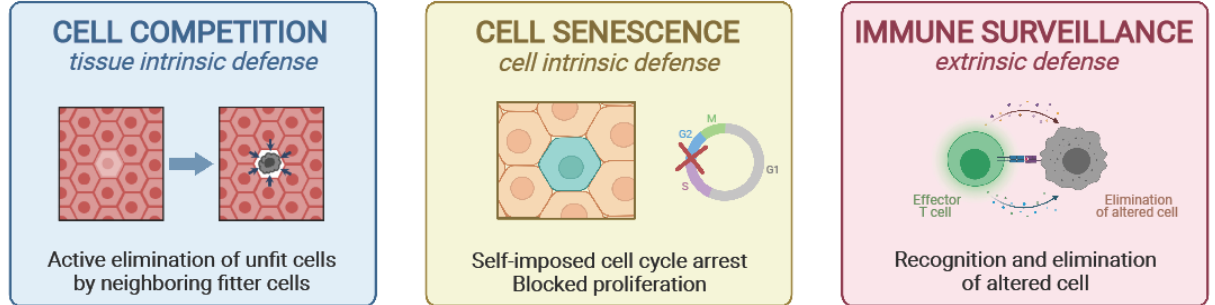
Figure 1. Protective mechanisms against cancer. The survival and proliferation of altered cells can be prevented by three main mechanisms. Cell competition ( left panel ) is a tissue intrinsic mechanism, where unfit cells can be actively eliminated by fitter surrounding cells; cell senescence ( central panel ) is a cell intrinsic mechanism, where altered cells enter a permanent state of mitotic block; immune surveillance ( right panel ) represents an important tissue extrinsic mechanism for the elimination of senescent or otherwise altered cells.